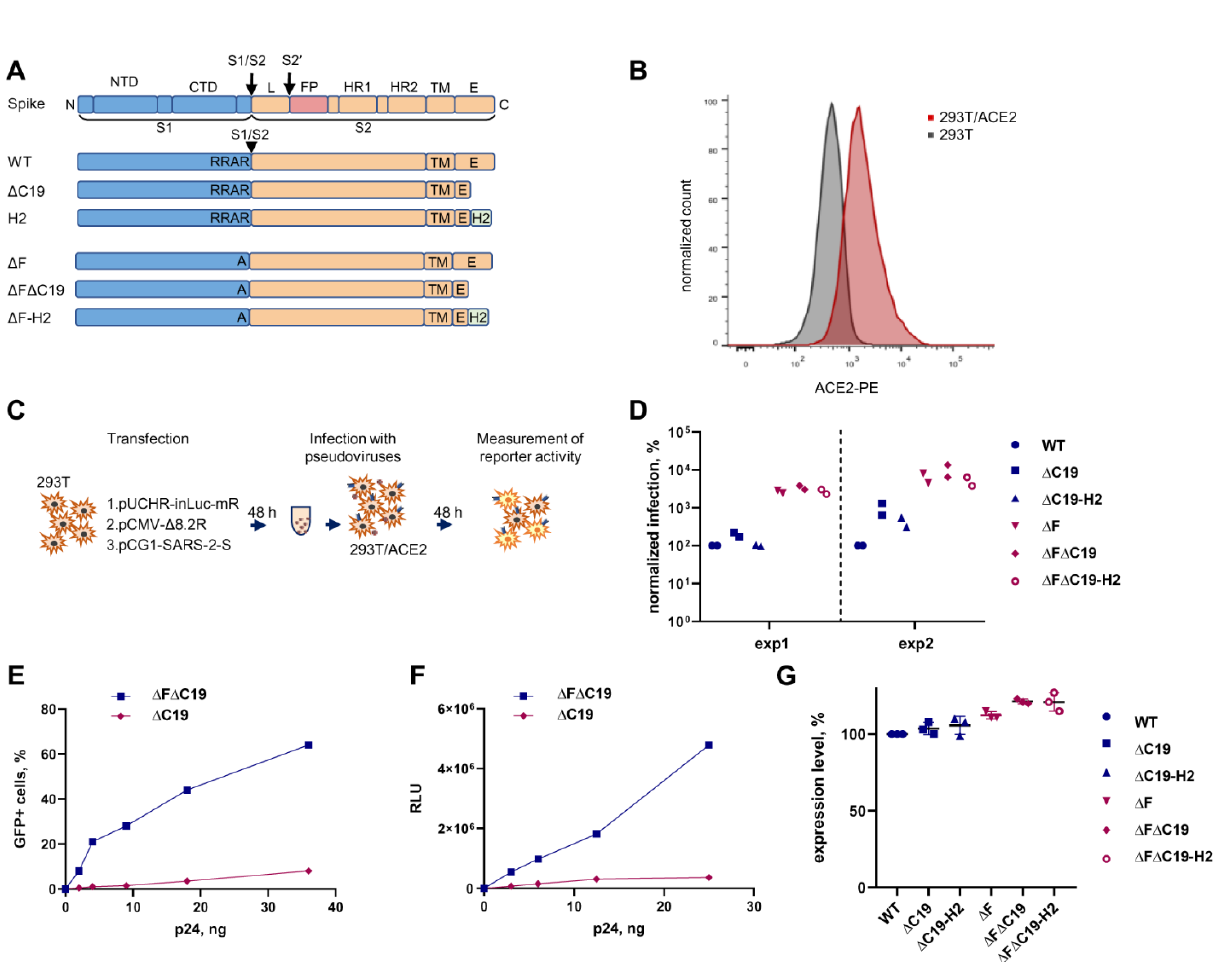
Figure 1. Development of a SARS-CoV-2 cell-free infection test with PVs. ( A ) A schematic illustration for S-protein variants used in pseudovirus infection tests. Six different constructs of the S protein were generated by PCR mutagenesis. ( B ) Evaluation of the ACE2 surface expression on 293T cells stably transduced with the hACE2 using flow cytometry. ( C ) Experimental setup for SARS-CoV-2 cell-free infection measurement. ( D ) The levels of infection detected with different variants of the S protein. PVs were added to 293T/ACE2 cells in an equal amount based on HIV-1 Gag quantification. The luciferase activity measured for a mutant spike was normalized to that obtained for the wild-type S protein. Two independent experiments with two different PV preparations were performed. ( E , F ) The levels of cell-free infection with indicated PVs were measured using either GFP ( E ) or inLuc ( F ) reporter. ( G ) The levels of S protein expression on PV- producing cells estimated by flow cytometry. To express indicated variants of protein S, 293T cells were transfected and stained with convalescent human serum in 48 h. Median fluorescence intensity (MFI) level was calculated for every mutant in the gate of transfected cells and normalized to the MFI detected for wild-type S